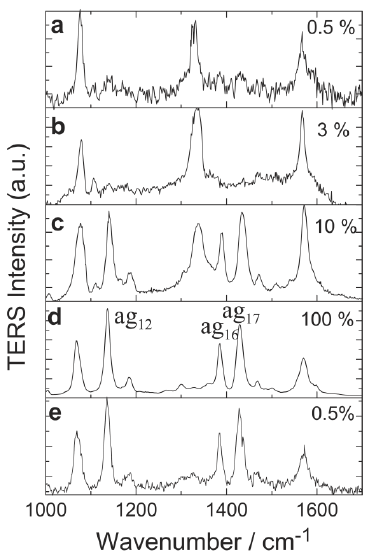
Figure 3. UHV-TERS spectra showing the dimerization of 4-nitrobenzenethiol (4NBT) to dimercaptoazobenzene (DMAB) molecules. Reprinted with permission from